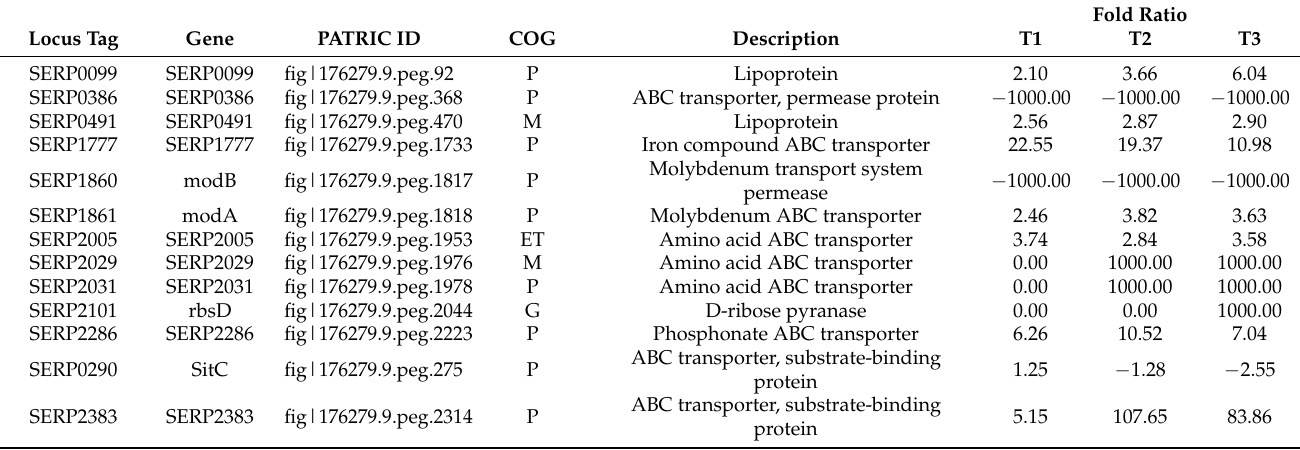
Table 5. Differentially expressed proteins associated with ABC transporter pathway.